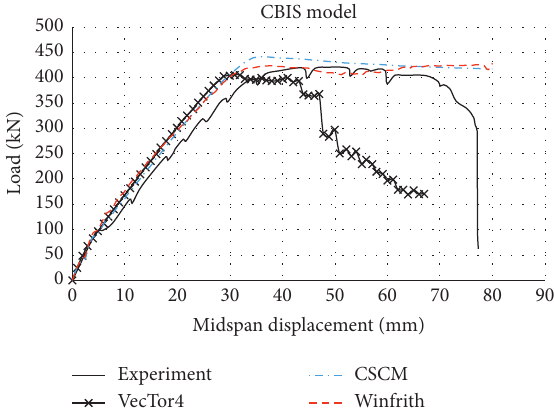
Figure 11: Numerical results by the CBIS model compared with the experimental test.